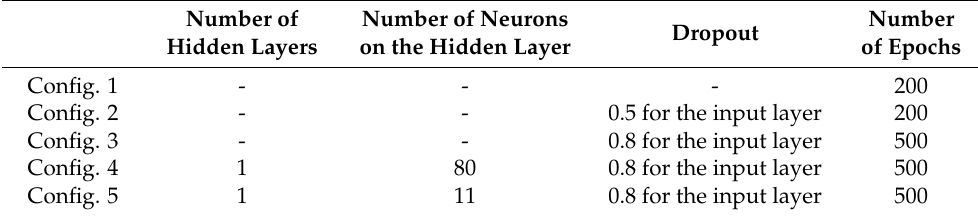
Table 9. Tested configurations for the non-overlapping dataset.